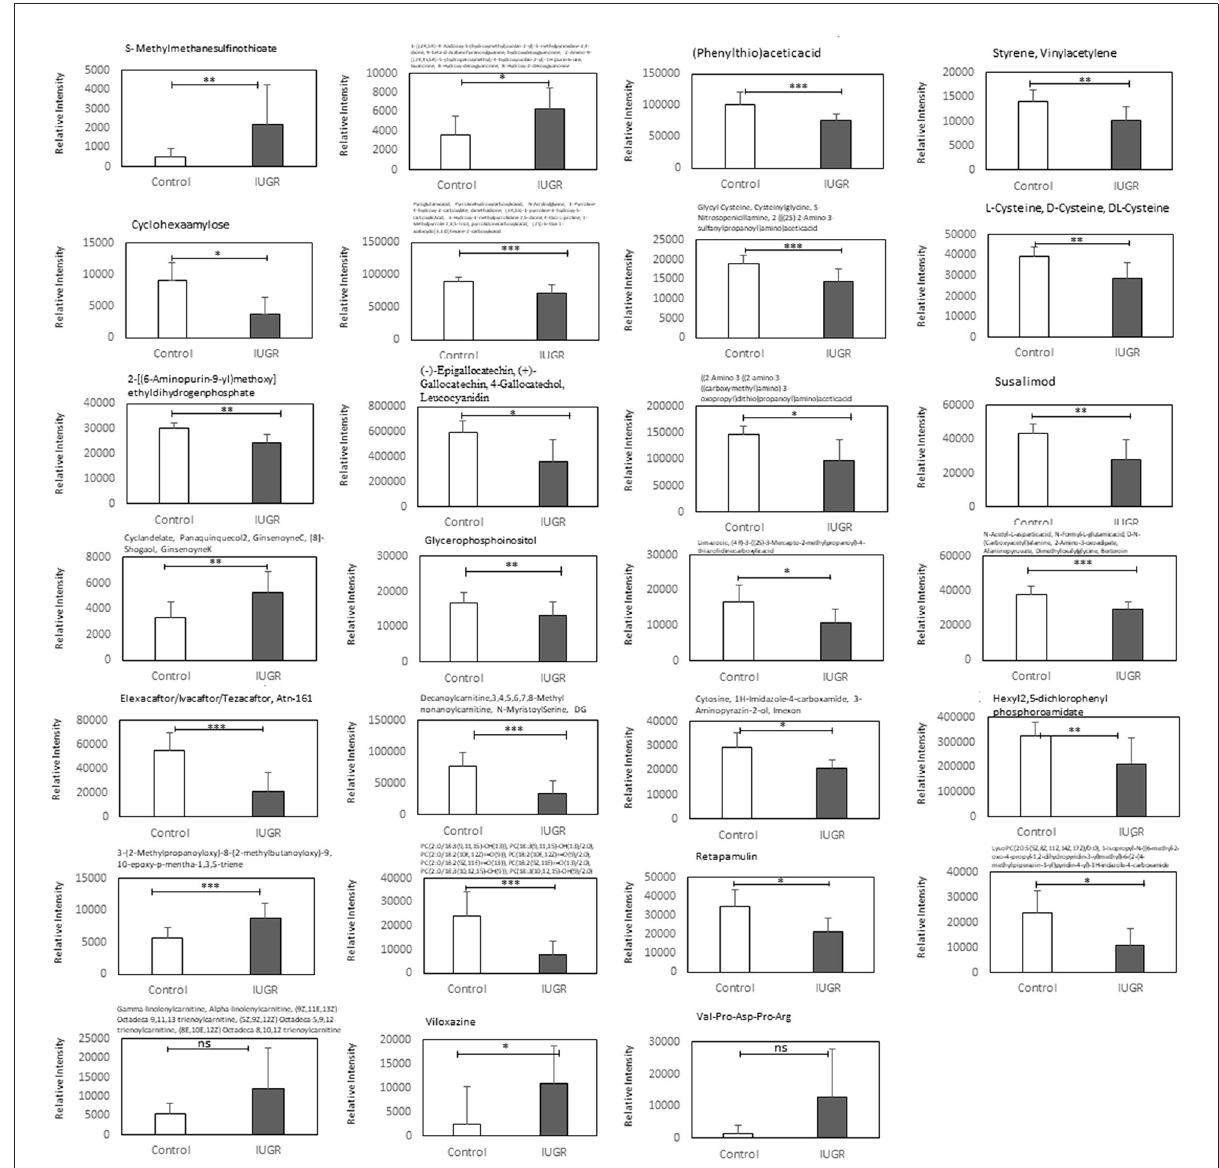
FIGURE6 Relative ion intensities of significantly differential metabolites in the control and IUGR rat lung tissue samples harvested on postnatal day 7 ( n = 5). Data are presented as means ± SDs. ns, not significant. * p < 0.05; ** p < 0.01; *** p <